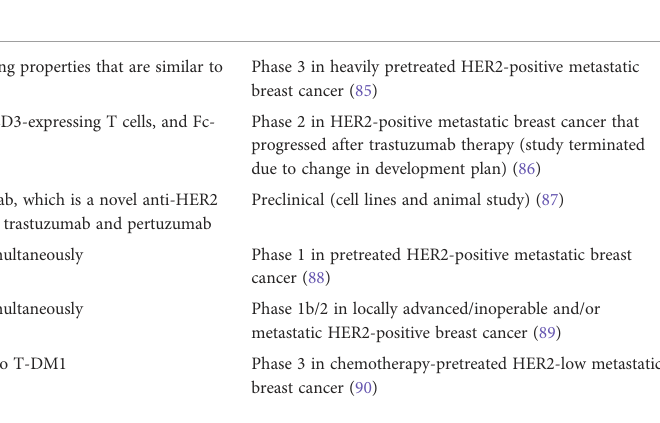
TABLE 2 Selected novel anti-her2 agents that are being developed. Novel Anti- HER2 Agents